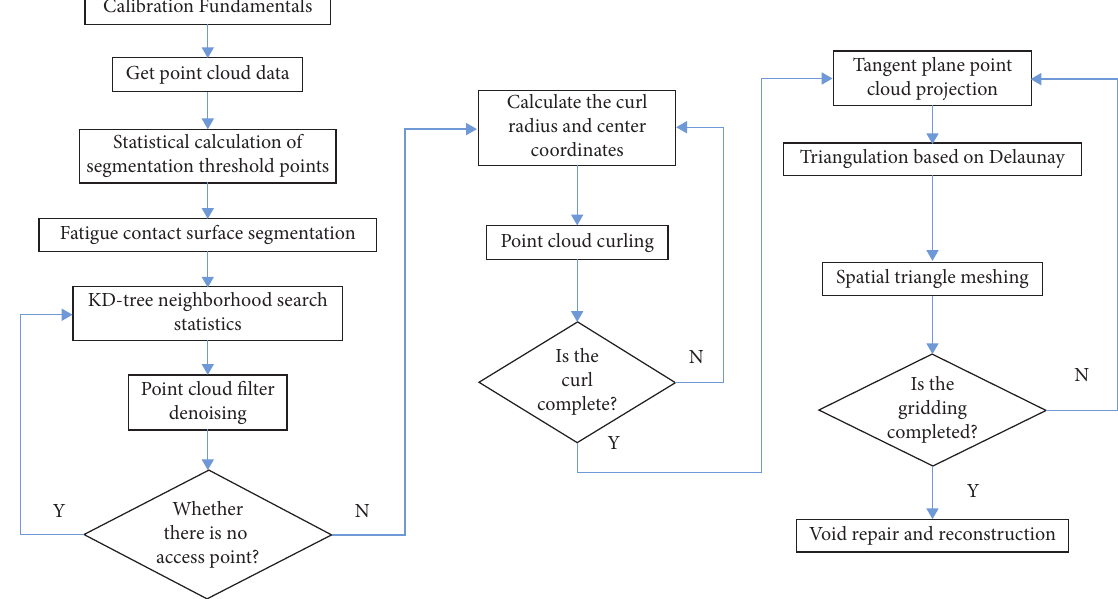
Figure 3: Flow chart of point cloud processing and 3D